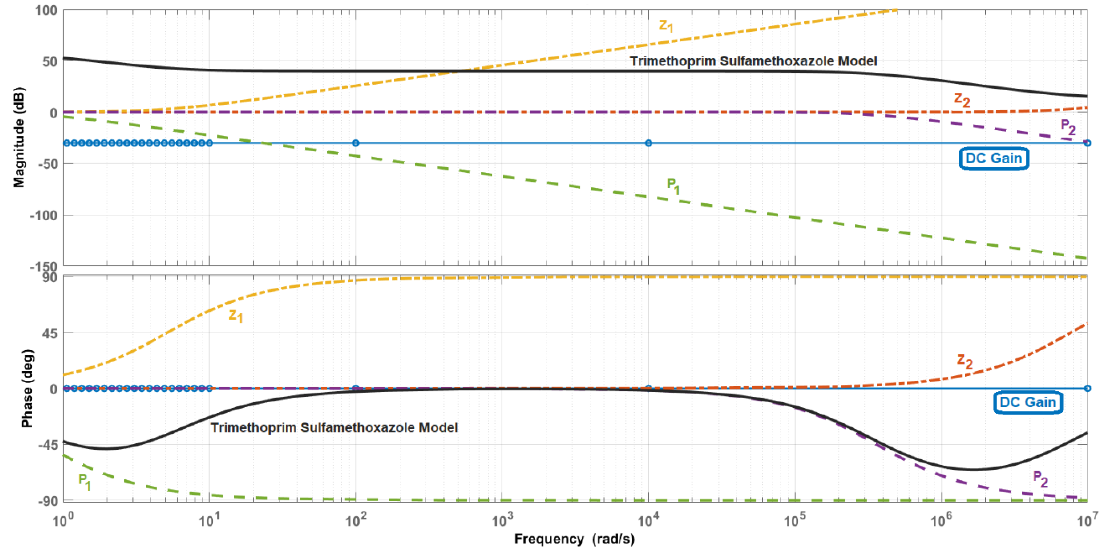
Figure 10. Bode plot of the Trimethoprim/Sulfamethoxazole model, showing the magnitude and phase contribution of each term. contribution of each term. Appl. Sci. 2020 , 10 , x FOR PEER REVIEW